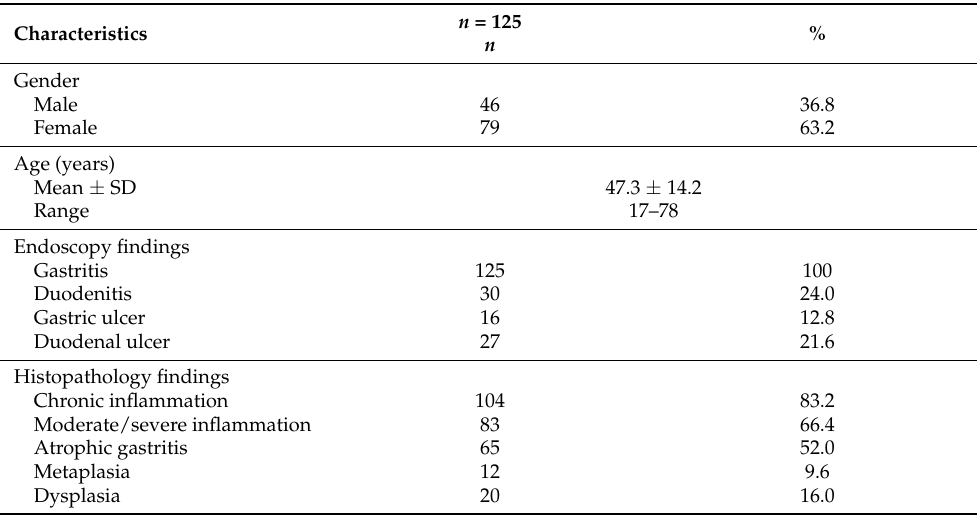
Table 1. Characteristics of studied